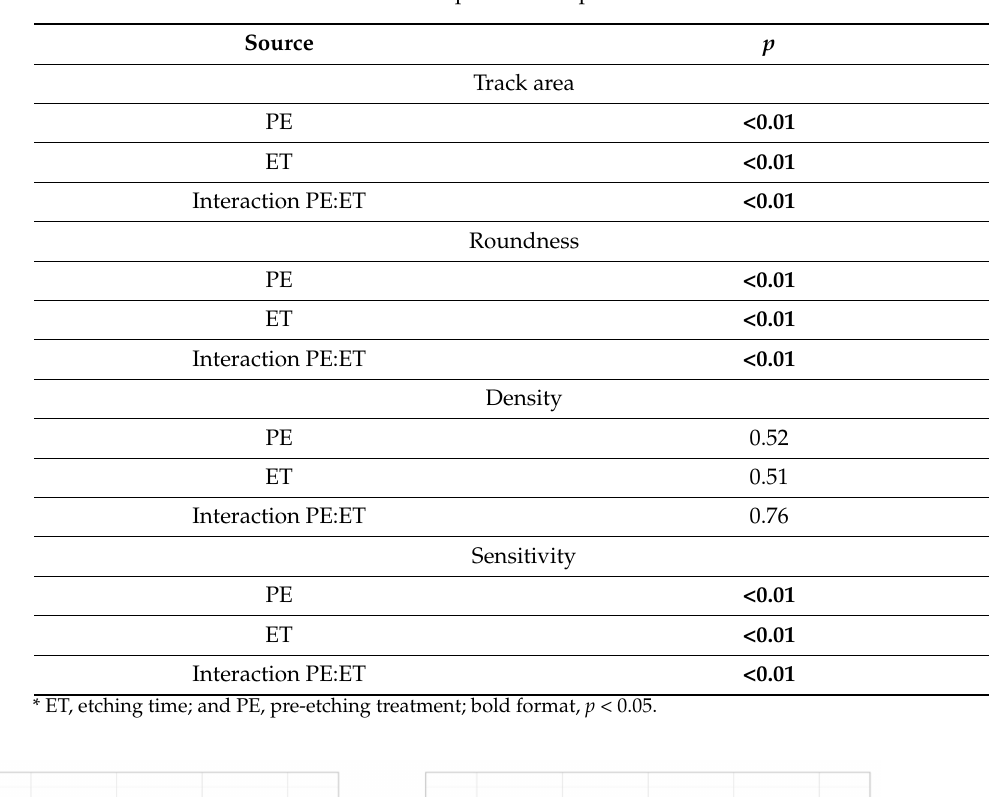
Table 10. ANOVA results for the 241 Am exposure in Experiment 2 *.